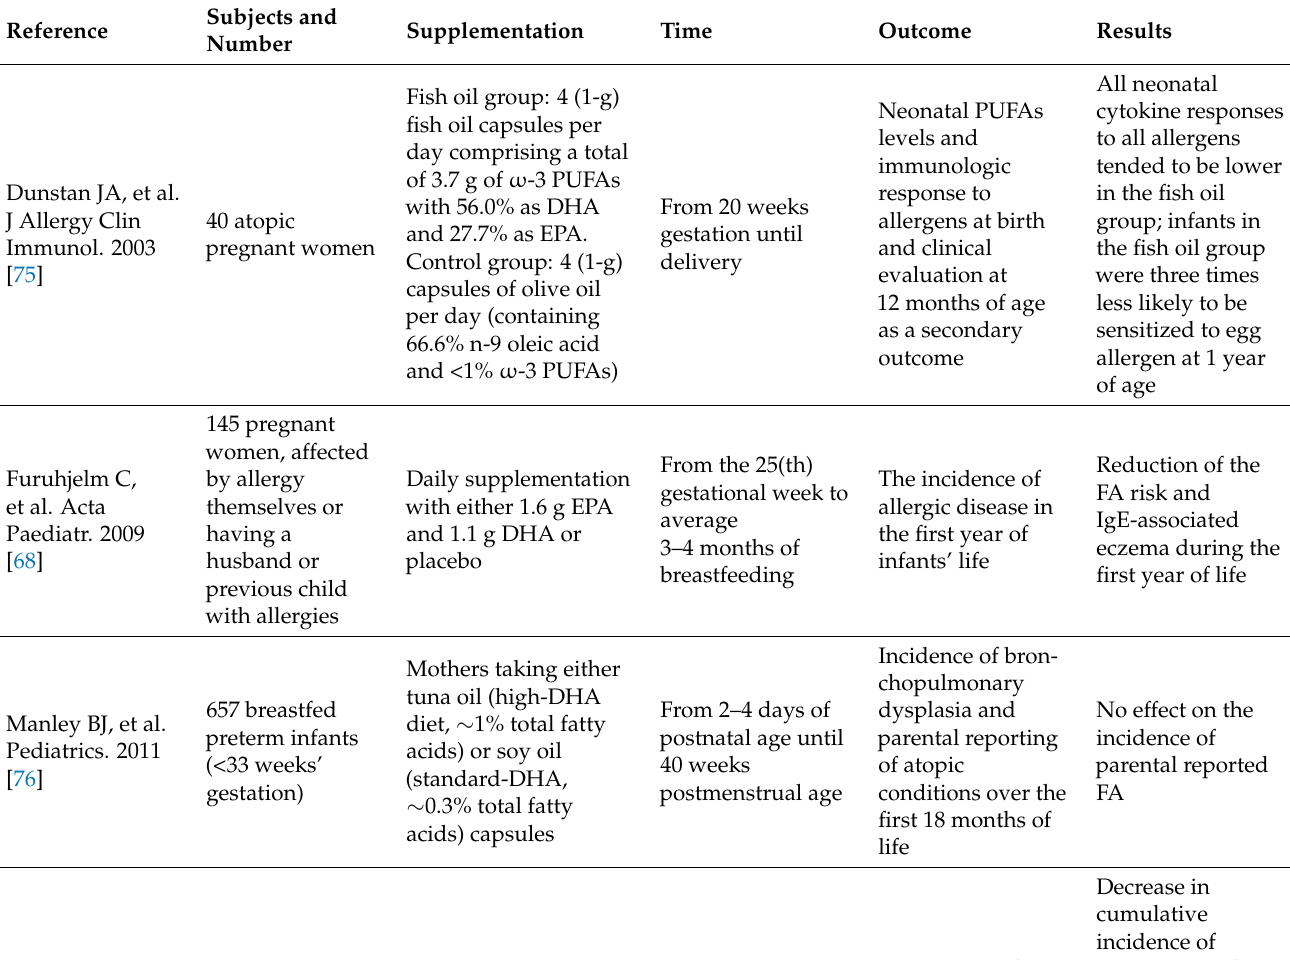
Table 3. Clinical evidence on ω -3 PUFAs supplementation and the occurrence of FA or food allergens